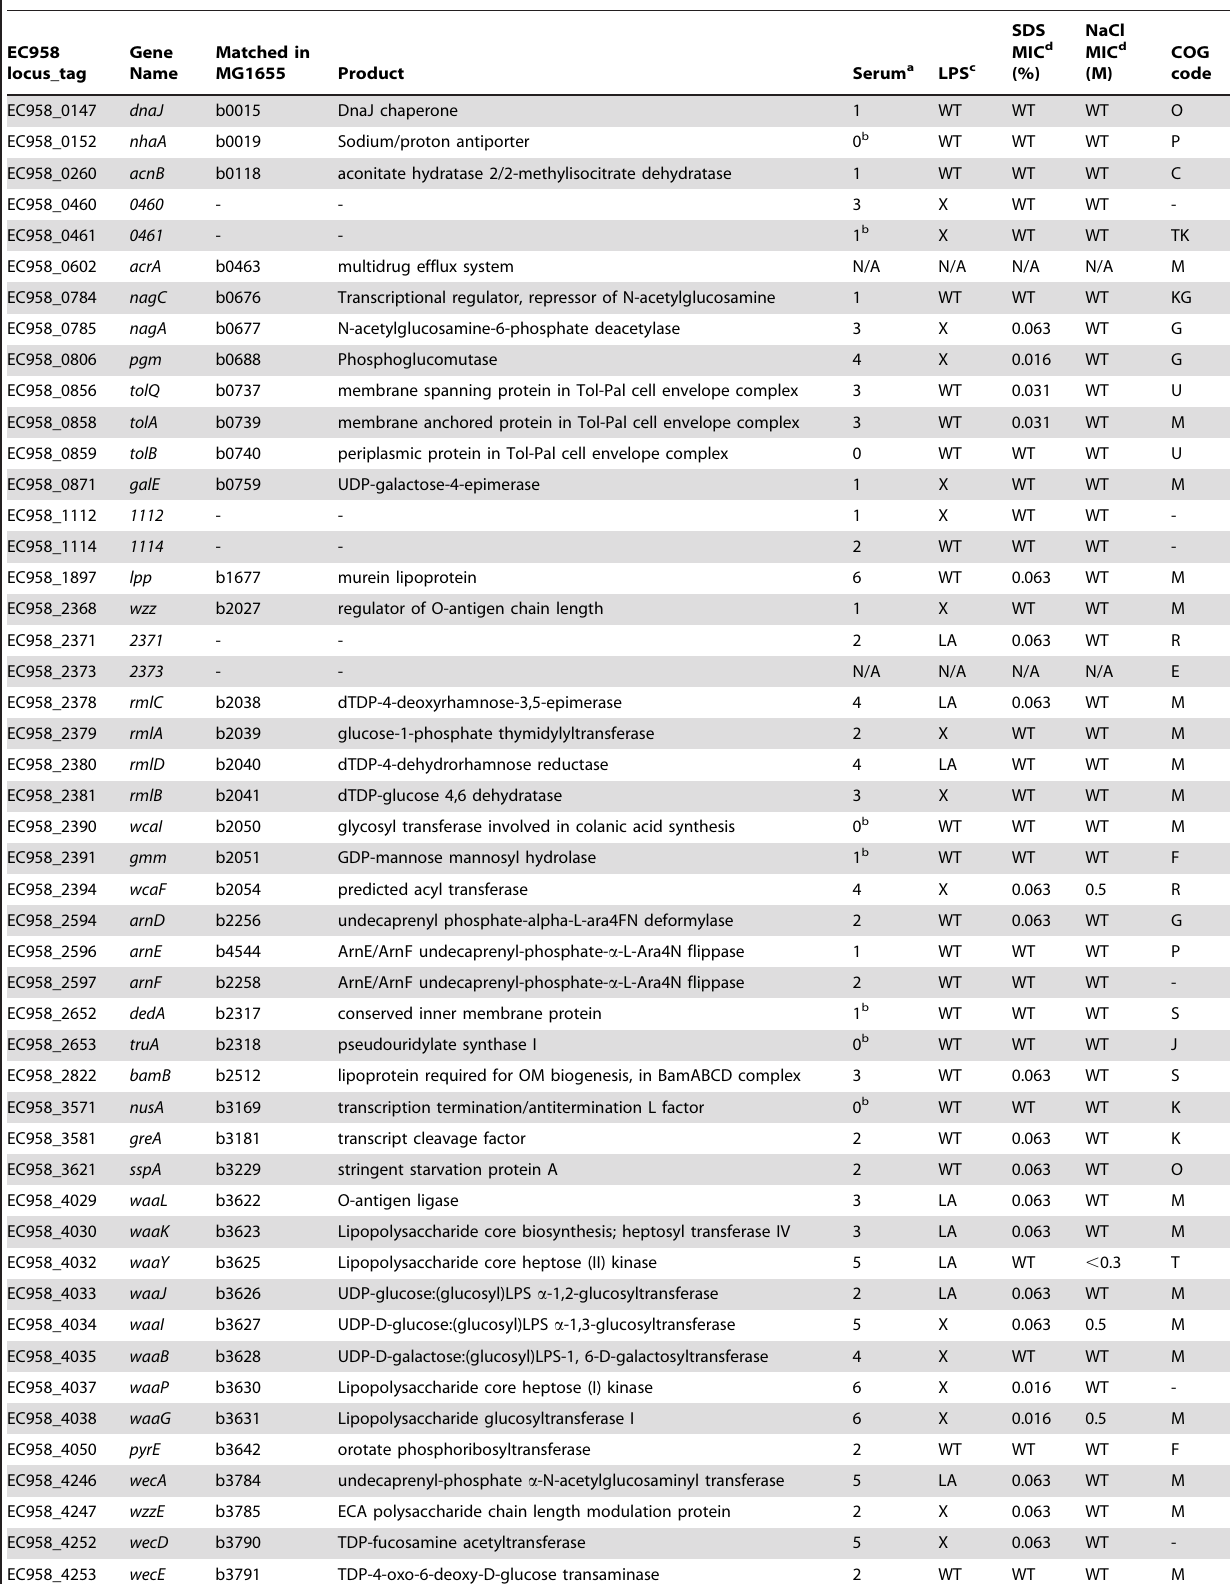
Table 2. Genes required for serum resistance identified by multiplexed